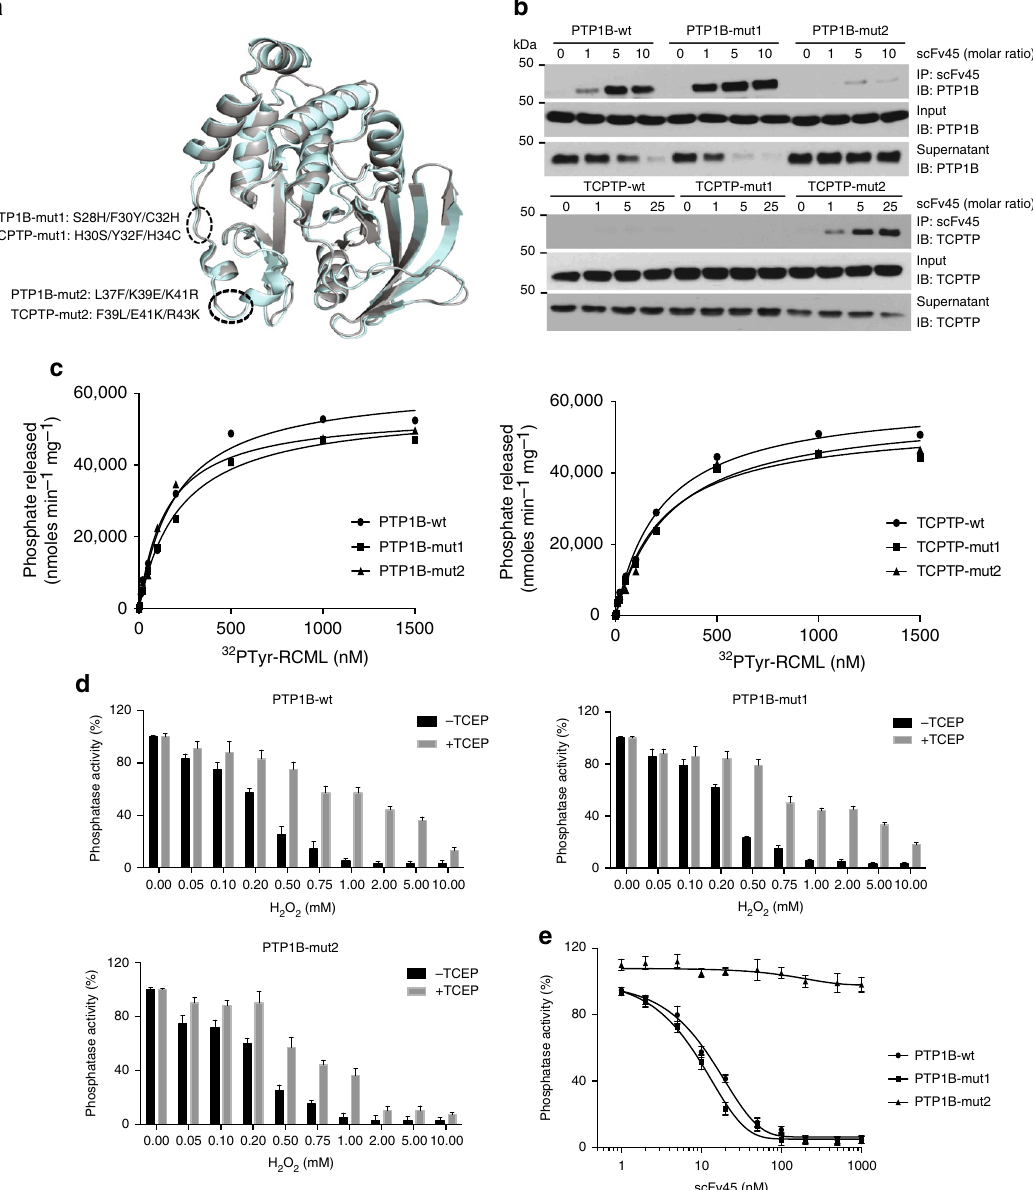
Fig. 1 Molecular characterization of PTP1B-scFv45 interaction. a Overlay of PTP1B (gray) and TCPTP (pale blue) crystal structures, highlighting residues that are changed in generating mutant forms (-mut1 and -mut2) of the enzymes. b Increasing concentrations of recombinant HA-tagged scFv45 were incubated with oxidized wild-type (-wt) or mutant (-mut) forms of PTP1B (top panel) and oxidized wild-type or mutant forms of TCPTP (bottom panel). The protein complexes were precipitated with anti-HA-agarose beads and equivalent amounts of input, supernatant, and eluate were subjected to immunoblot analysis. Data are representative of at least three independent experiments ( n = 3). c Michaelis – Menten plots for wild-type (circle), -mut1 (square), or -mut2 (triangle) forms of PTP1B (left) and TCPTP (right) are shown. Radiolabeled 32 PY-RCML was used as substrate to measure phosphatase activity. Individual data points represent the mean obtained from three separate experiments ( n = 3). d Wild-type and mutant forms of PTP1B were incubated with increasing concentrations of H 2 O 2 and phosphatase activity was measured using DiFMUP in the absence (black bar) and presence (gray bar) of the reducing agent TCEP (5 mM). e Oxidized PTP1B-wt (circle), PTP1B-mut1 (square), or PTP1B-mut2 (triangle) were incubated with increasing concentration of scFv45 (0 – 1000 nM) and phosphatase activity was measured using DiFMUP as substrate in the presence of the reducing agent TCEP (5 mM). Data represent mean ± s.e.m. from three separate experiments ( n = 3; d , e